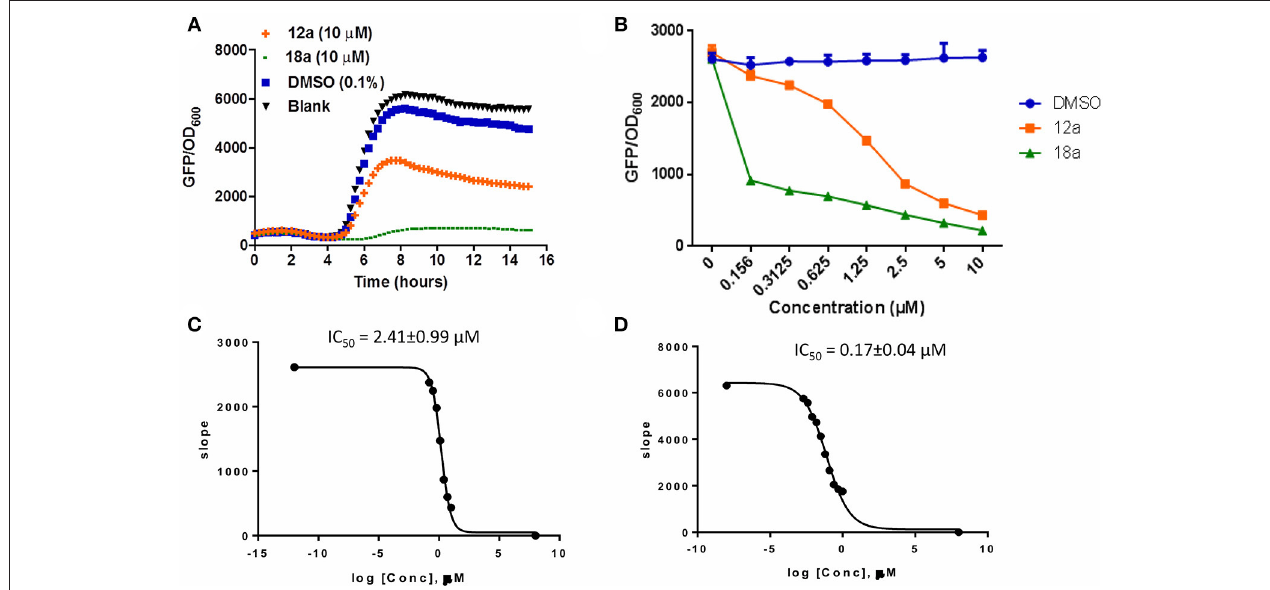
FIGURE 1 | (A) Effects of compounds 12a and 18a on PAO1- lasB-gfp reporter strain. DMSO 0.1% was used as solvent control. (B) Dose-response effects of compounds on P. aeruginosa lasB-gfp. (C) IC 50 values of 12a and 18a (D) on lasB-gfp. Calculation was done using GraphPad Prism 6 software, taken at time point between 4 and 6h when QS inhibition started to occur. All experiments were done in triplicate manner (technical and biological replicates), only representative data are shown.